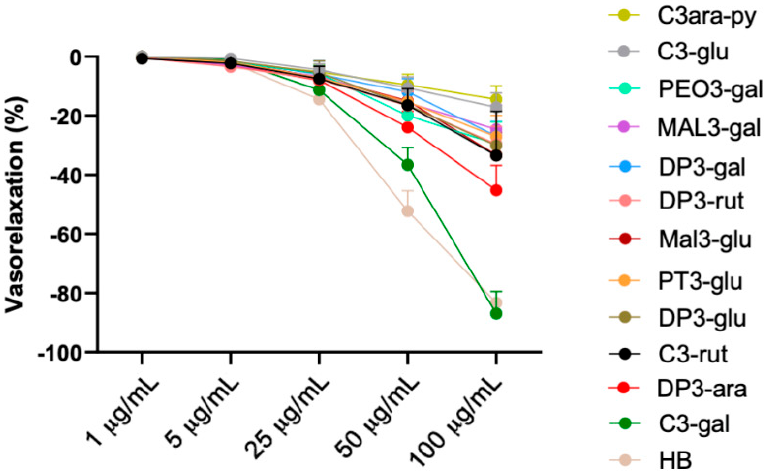
Figure 3. Characterization of vascular action of single anthocyanins. Vascular response of phenylephrine-precontracted mice mesenteric arteries to increasing doses of single anthocyanins, cyanidin-3-arabinopyranoside (C3-ara-py) ( N = 5), cyanidin-3-glucoside (C3-glu) ( N = 6), peonidin-3-galactoside (PEO3-gal) ( N = 3), malvidin-3-galactoside (MAL3-gal) ( N = 3), delphinidin-3-galactoside (DP3-gal) ( N = 3), delfinidin-3-rutinoside (DP3-rut) ( N = 6), malvidin-3-glucoside (MAL3-glu) ( N = 3), petunidin-3-glucoside (PT3-glu) ( N = 6), delphinidin-3-glucoside (DP3-glu) ( N = 8), cyanidin-3-rutinoside (C3- rut) ( N = 7), delphinidin-3-arabinoside (DP3-ara) ( N = 5), cyanidin-3-galactoside (C3-gal) ( N = 3), and HB ( N = 5) (1–100 µg/mL).